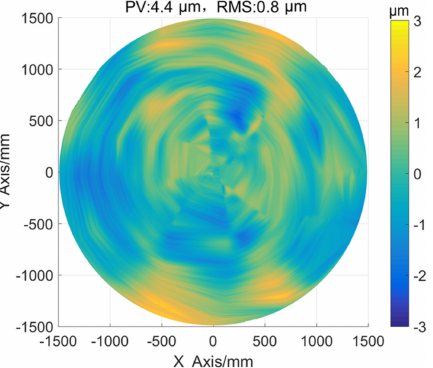
Figure 6. Surface map obtained by laser tracker using a non-contact